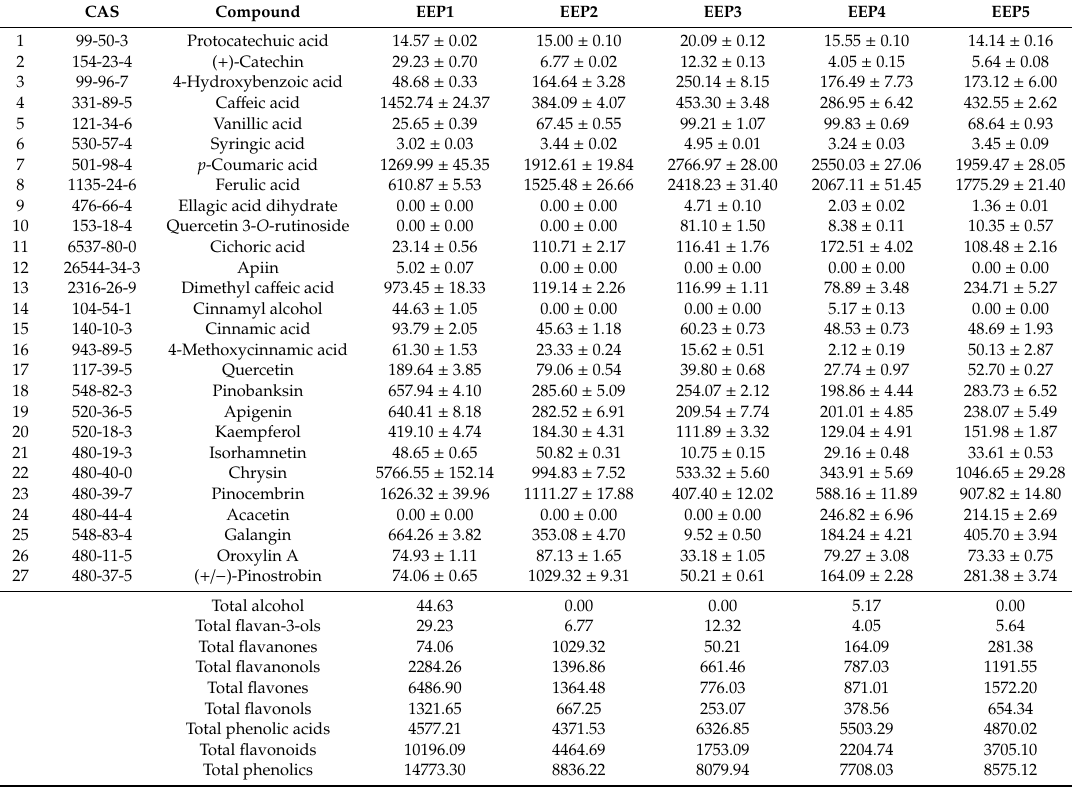
Table 2. The chemical composition of ethanol extracts of propolis (EEP) [mg / 100 mL].